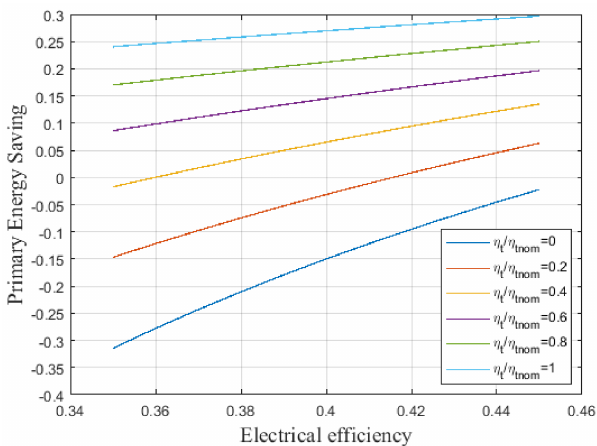
Figure 2. Primary energy saving (PES) as function of the combined heat and power (CHP) plant’s electrical efficiency for different ratios of the nominal thermal power actually exploited (the chart is representative of CHP plants adopting a reciprocating internal combustion